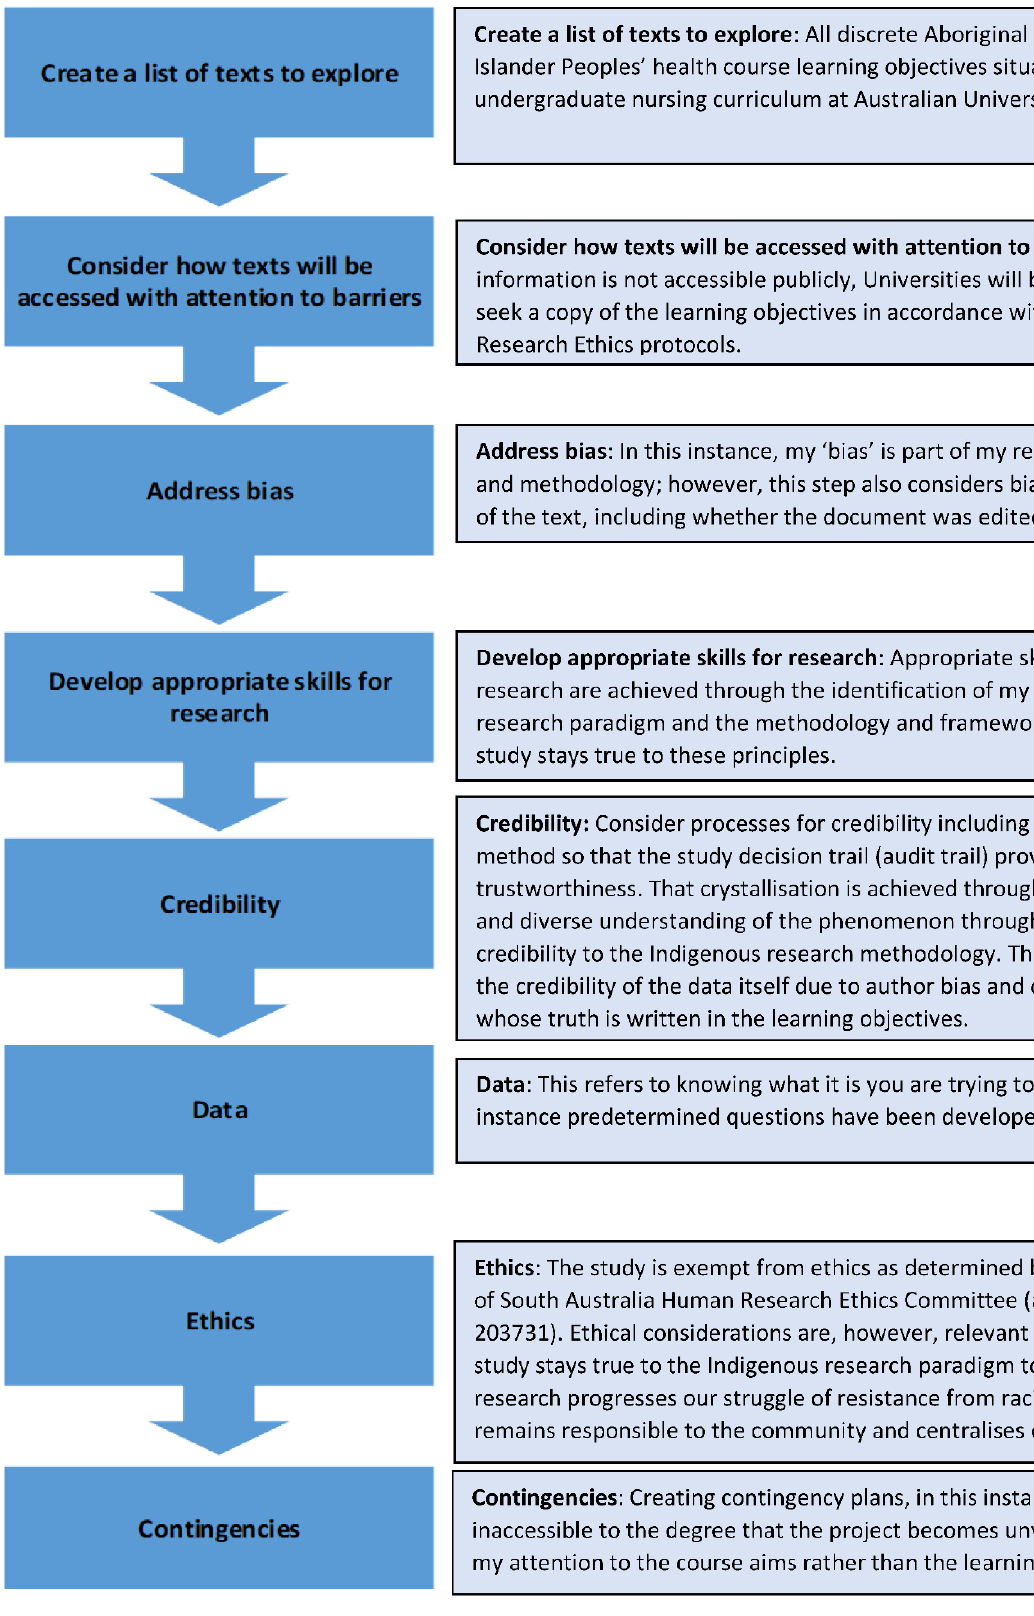
Figure 1. Eight-step planning process for textual analysis adapted from O’Leary [72] .